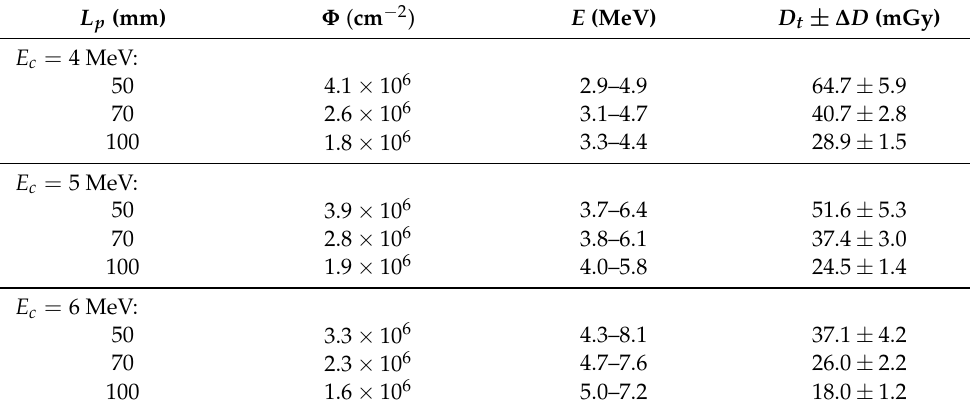
Table 1. Simulated particle numbers, energy intervals, and corresponding radiation doses on the cell sample for different pinhole